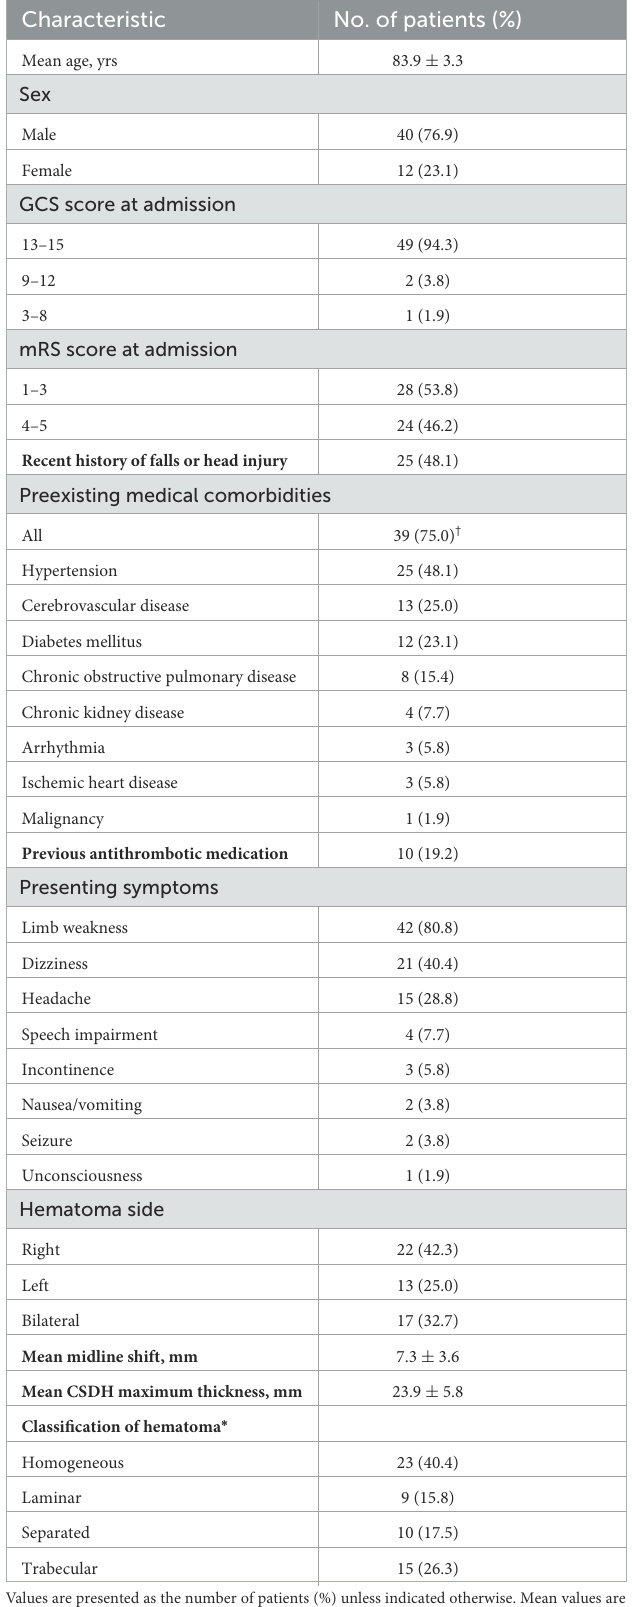
TABLE 1 Baseline characteristics of 52 patients with CSDH aged ≥ 80 years old who underwent SEPS.